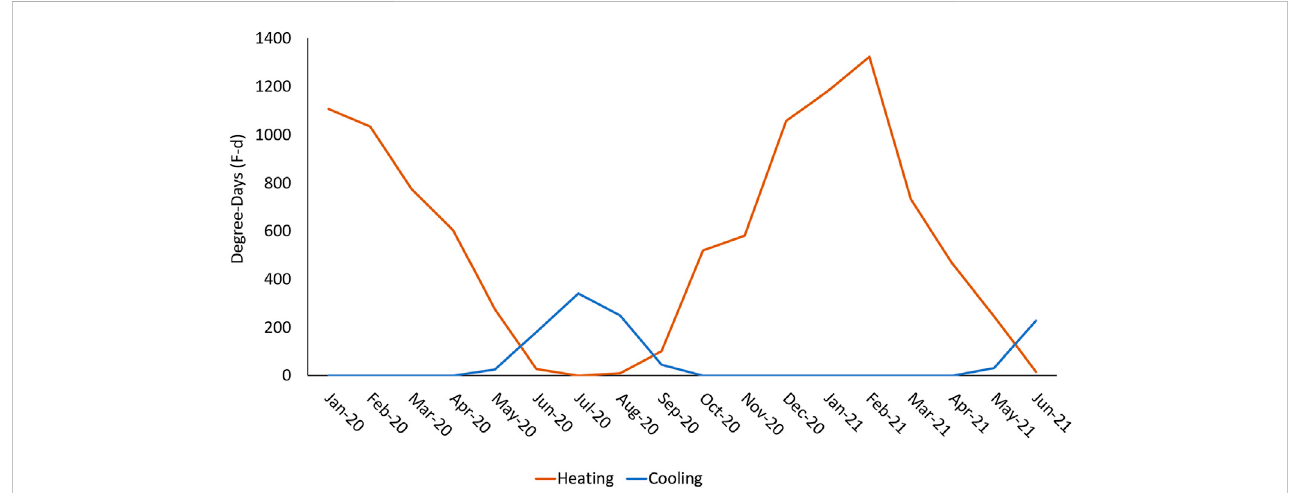
FIGURE 6 Monthly heating and cooling degree-days in Lake County, IL during the study period (NOAA, 2022).